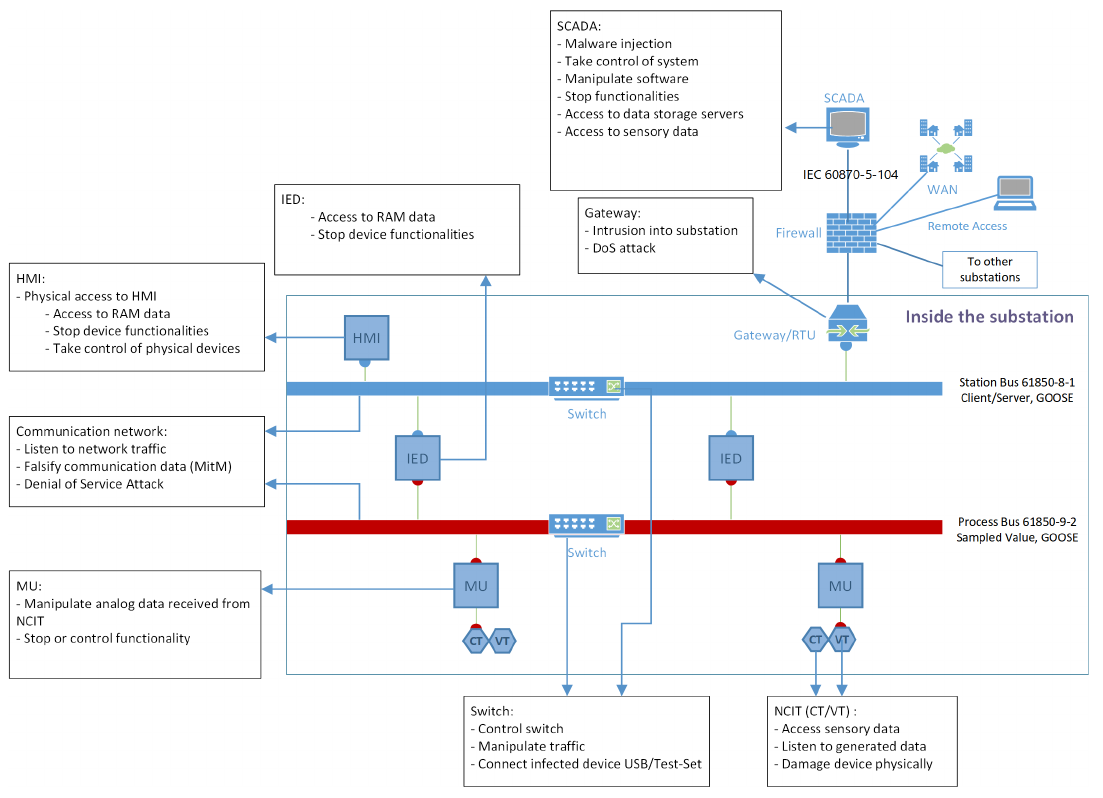
Figure 5. The security map as an initial step of threat analysis